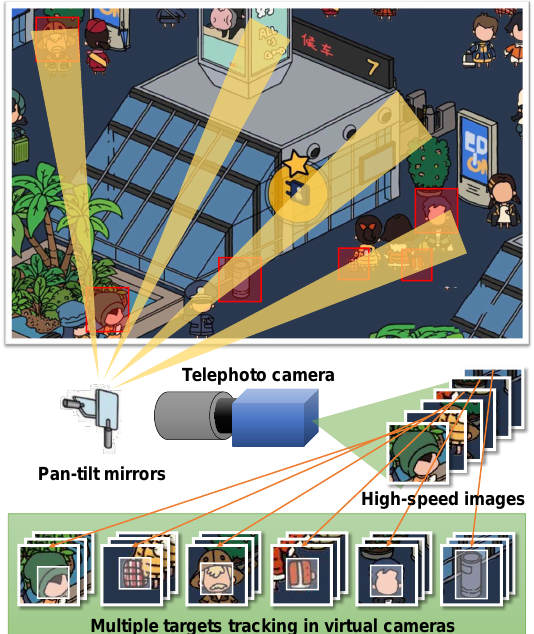
Figure 2. Wide field of view registration and multi-object tracking by virtual cameras using a galvanometer-based reflective PTZ camera.